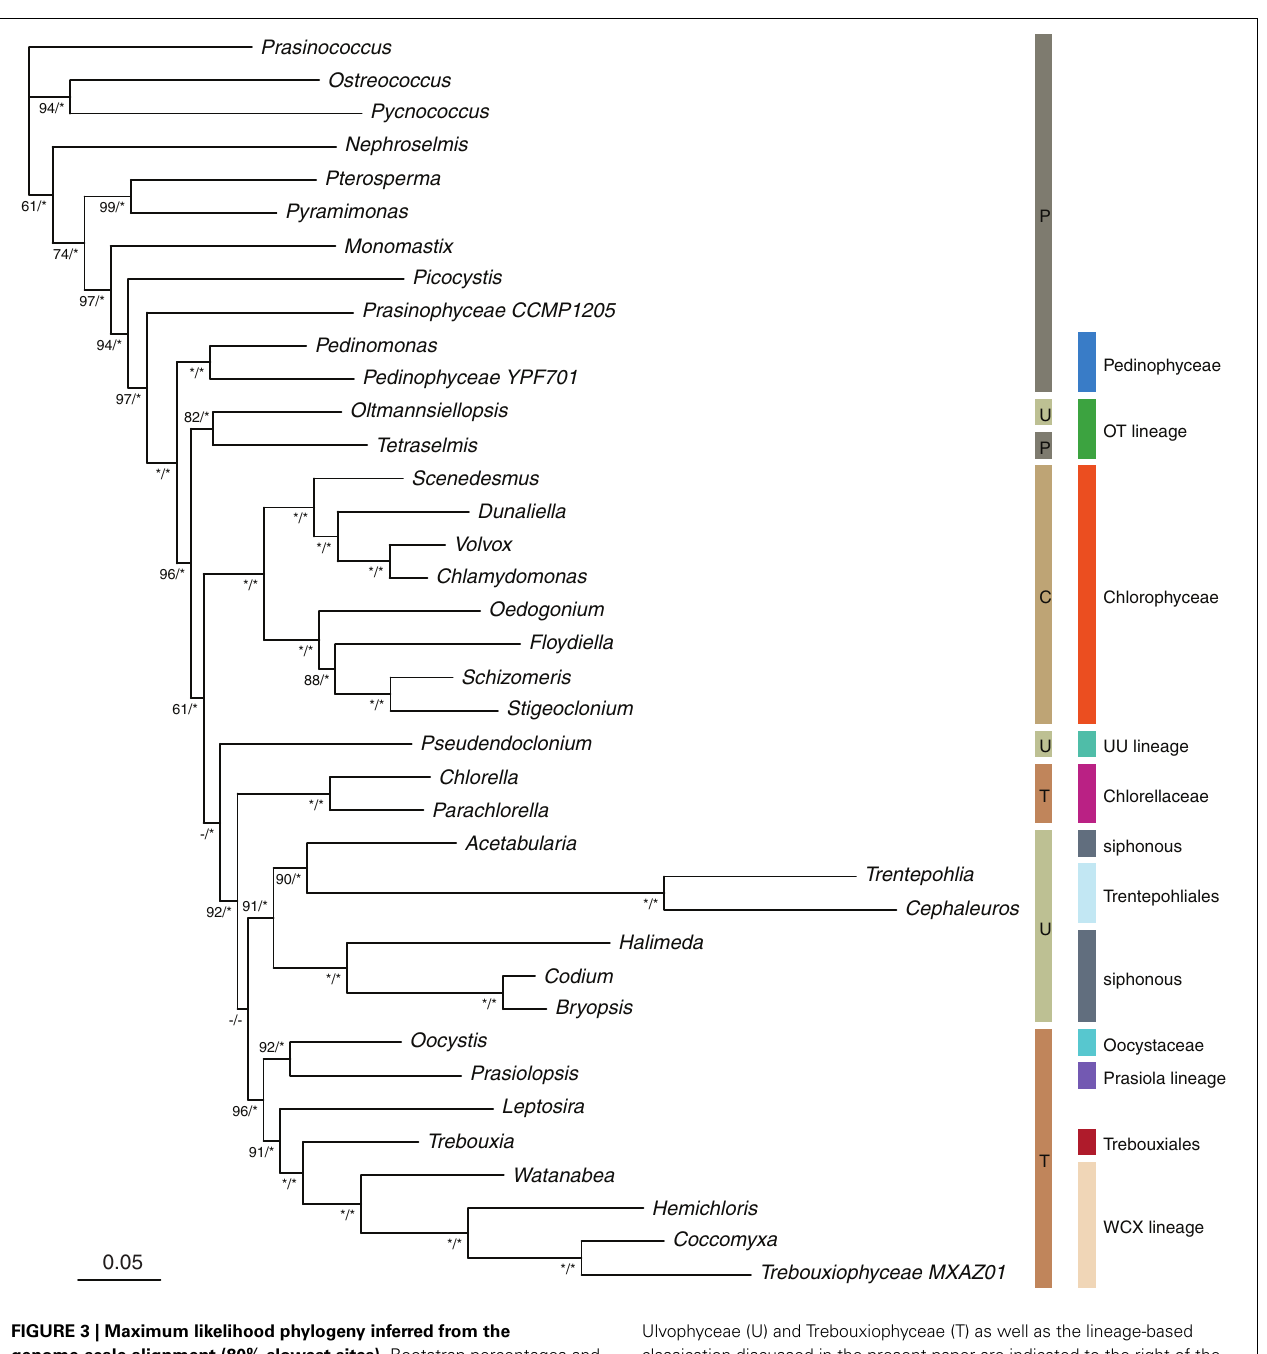
Ulvophyceae (U) and Trebouxiophyceae (T) as well as the lineage-based classication discussed in the present paper are indicated to the right of the phylogeny. Values under 60 BS and 0.90BPP are indicated as -, values of 100BS and 1.00BPP as ∗